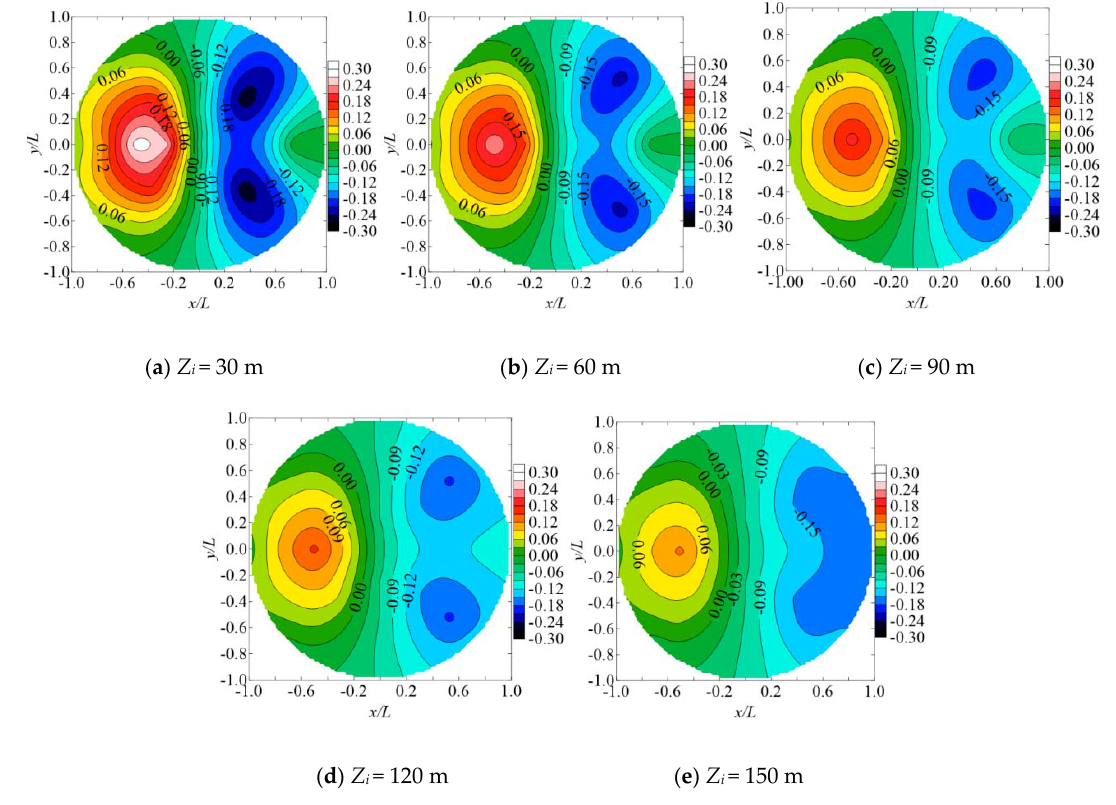
Figure 12. The vertical wind component ratio S w at different heights.